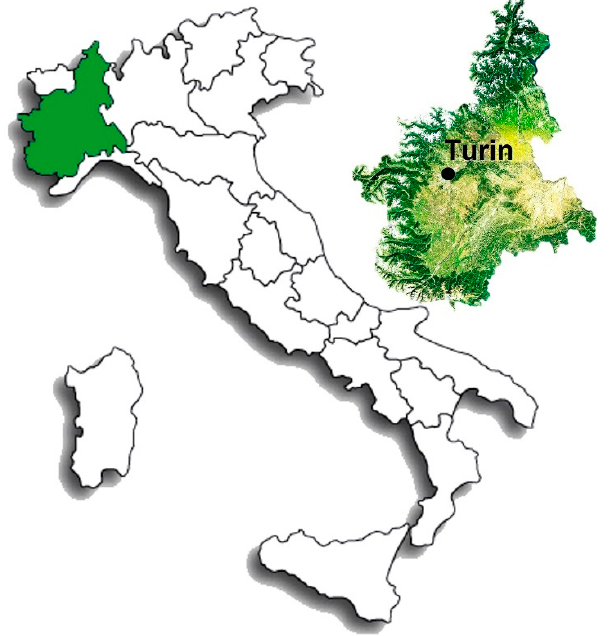
Figure 1. Localization of the study area in Piedmont (Italy).